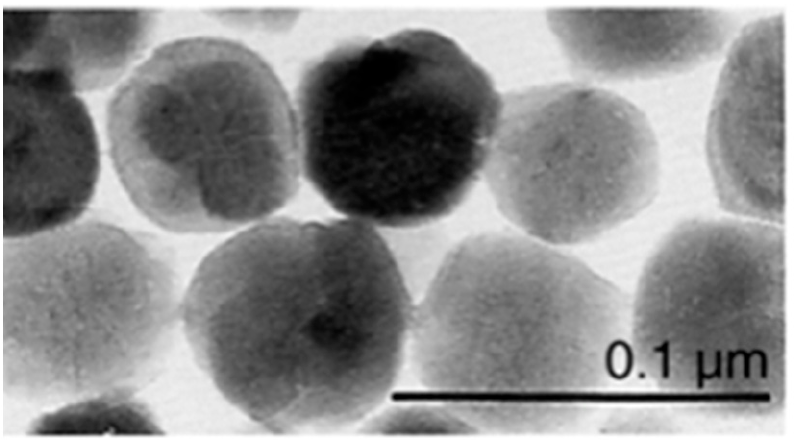
Figure 3. TEM images of spherical crystallites of hematite.